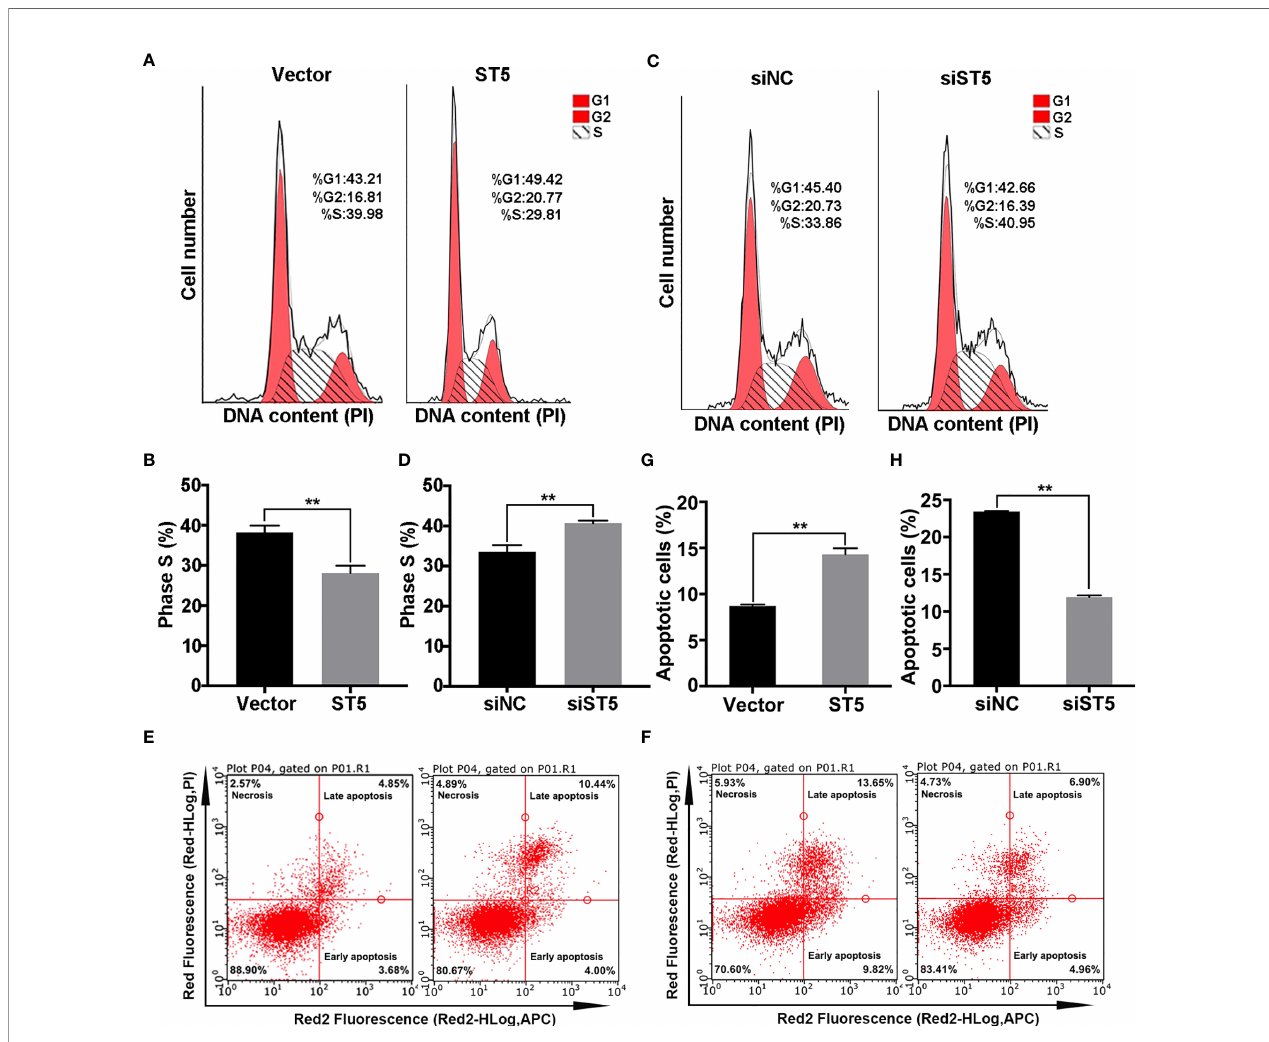
FIGURE 4 | Effect of ST5 on cell cycle and apoptosis of MDA-MB-231 cells. (A) Cell cycle progression was analysed in MDA-MB-231 cells transfected with Vector and ST5 plasmids. (B) Quantitative analysis of the proportion of phase S cells in panels (A, C) Cell cycle progression was analysed in MDA-MB-231 cells transfected with negative control siRNA and ST5-siRNA (siST5). (D) Quantitative analysis of the proportion of phase S cells in panel (C) The effect of ST5-upregulation on cell apoptosis (E) or effect of ST5-downregulation on cell apoptosis (F) were analysed by fl ow cytometry. Quantitative analysis of the proportion of apoptotic cells in the vector and ST5 groups (G) and in the siNC and siWDR41 groups (H) was presented. * indicated cells transfected with ST5-overexpressing plasmid or siST5 vs . Vector or siNC, respectively. *P < 0.05, **P <